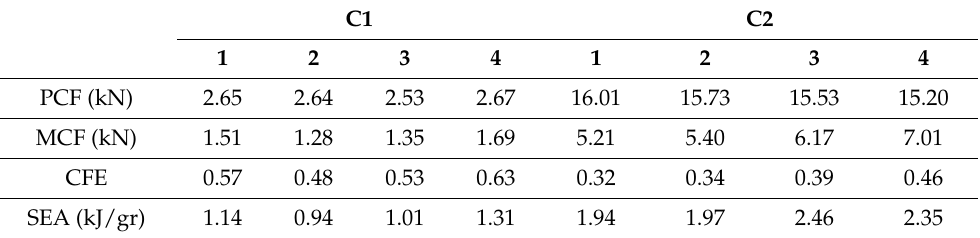
Table 5. Crush indexes for C1 and C2.